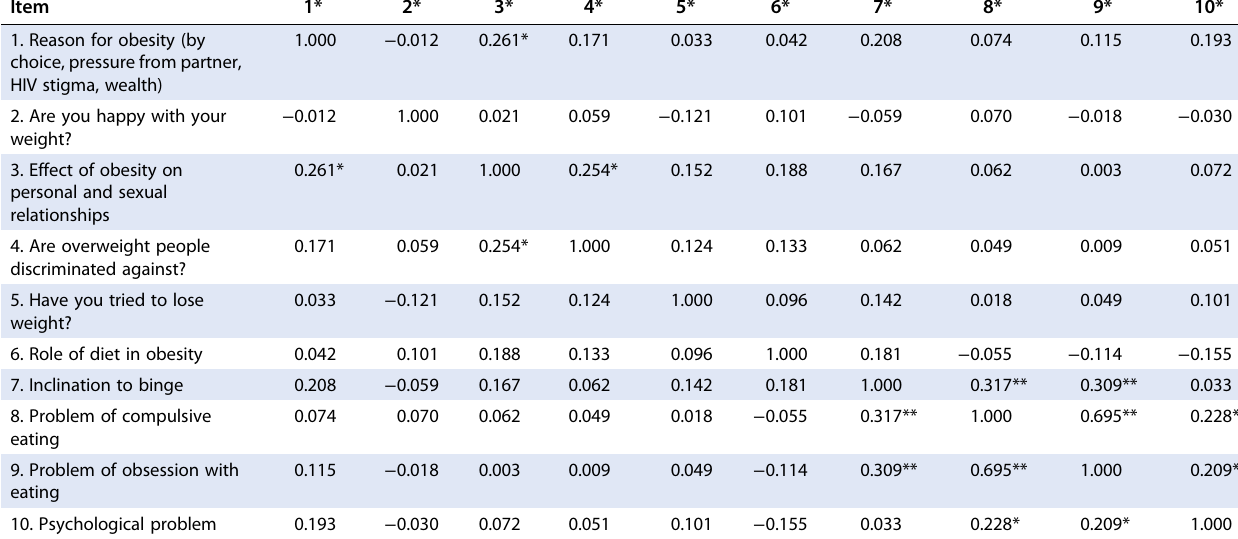
Table 5: Correlations between weight perceptions and eating behaviours